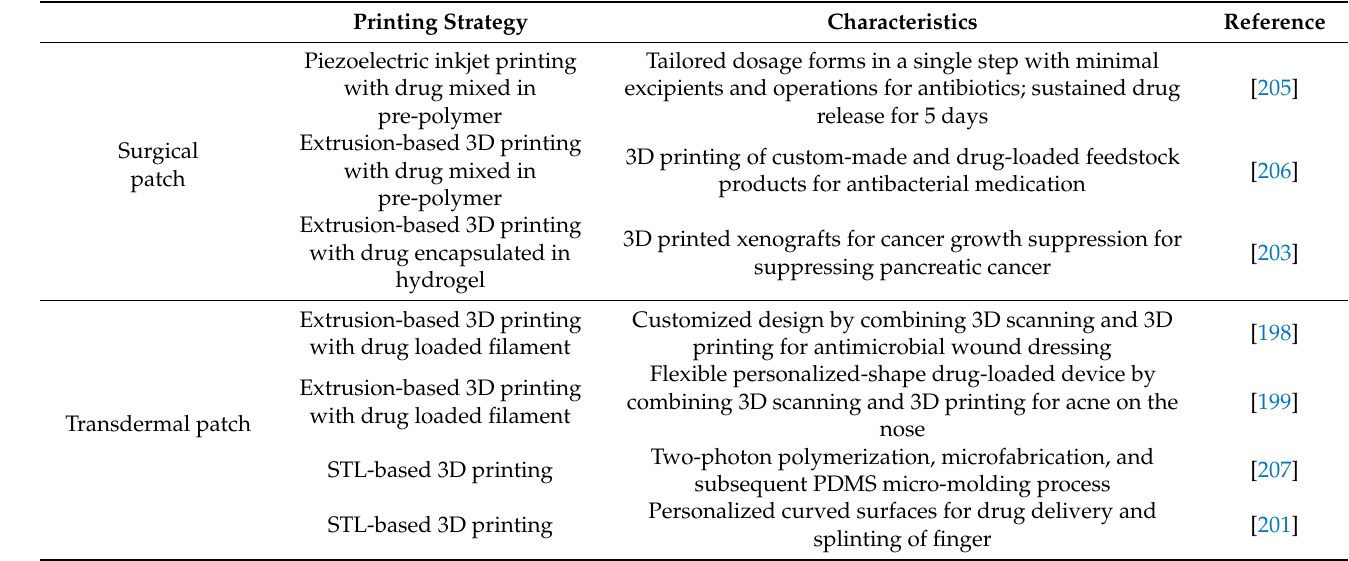
Table 3. Representative pharmaceutical application of 3D printed localized drug delivery. Printing